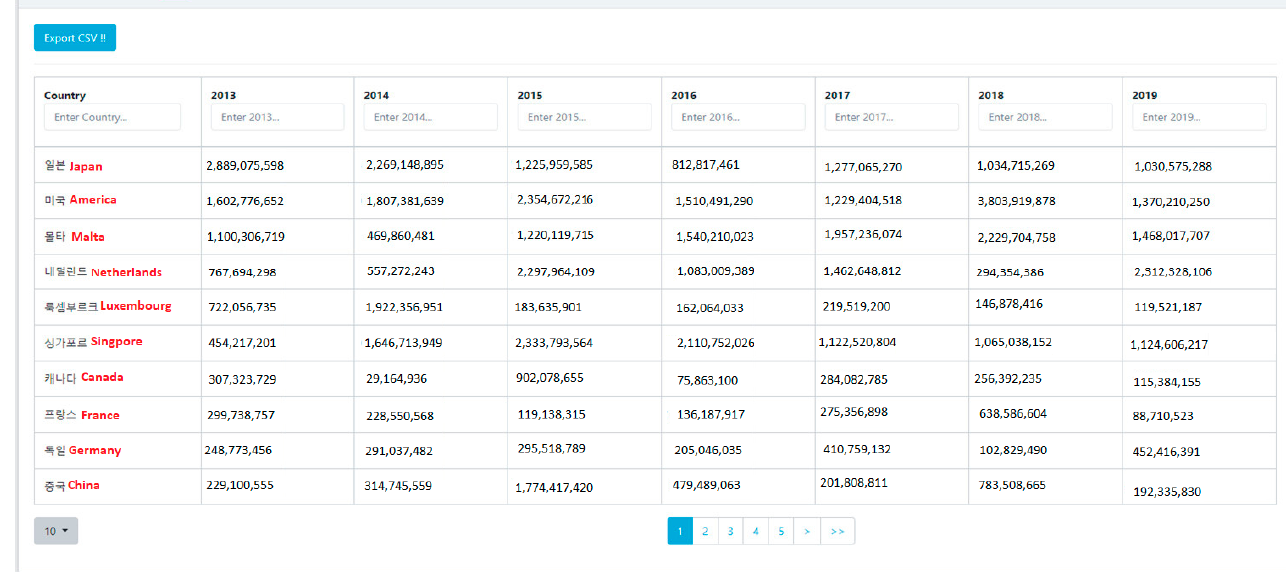
Figure 23. Data statistics of investment trends.